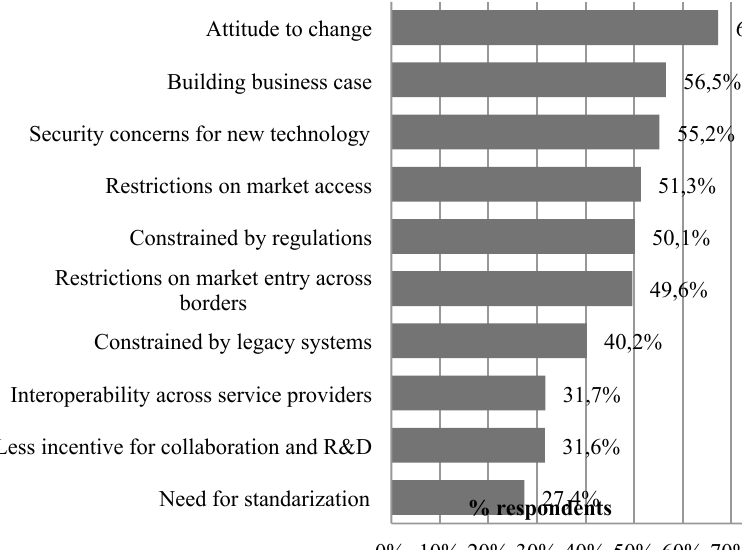
Fig. 3. Key retail payment innovations barriers (% of